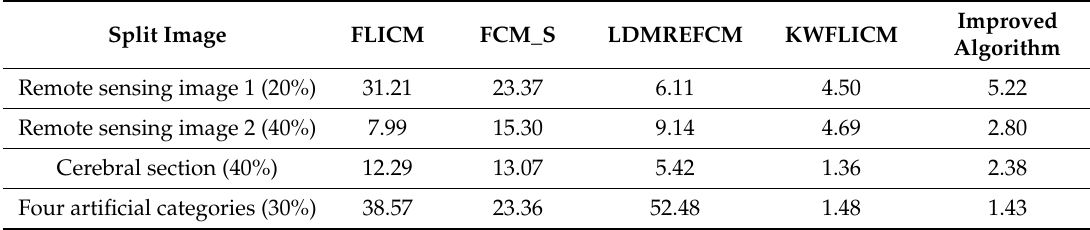
salt-and-pepper